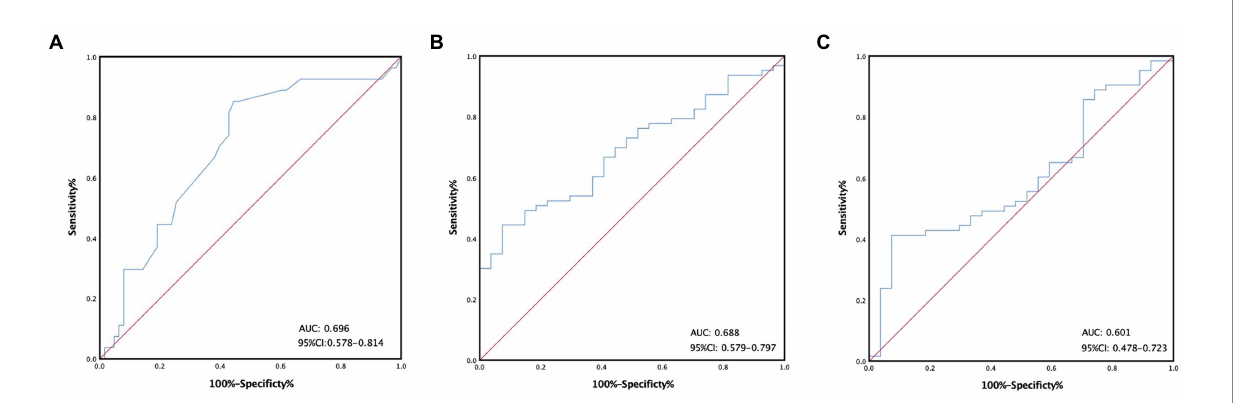
FIGURE 1 Receiver operating characteristic curves stratified by the different calcium (A) , platelet-to-lymphocyte ratio (B) , monocyte-to-white ratio (C) groups in patients with malignant pleural